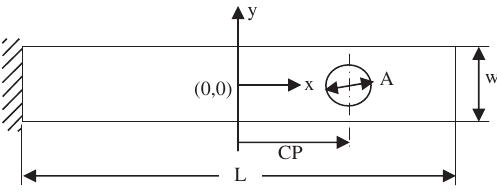
Figure 7 Cutout position of laminated composite plate.